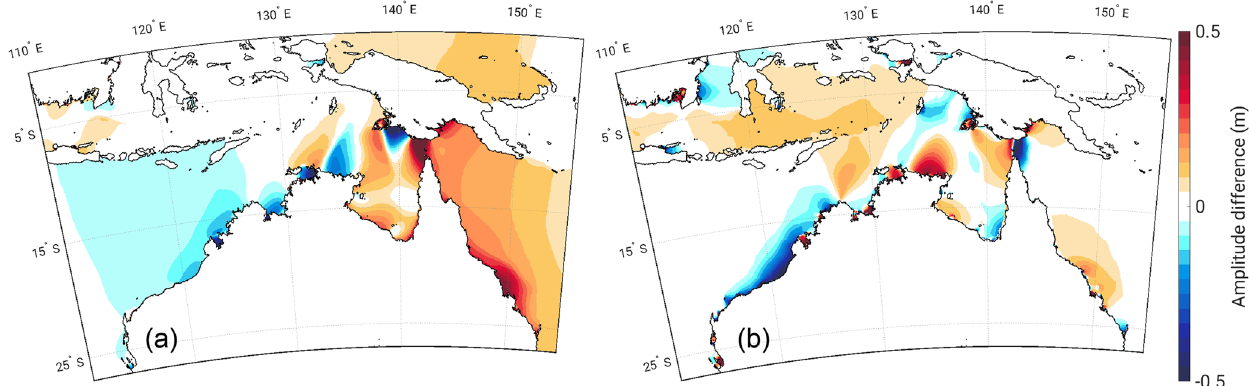
Figure 7. The difference in M 2 amplitude (m) between the FL and control simulation (i.e. FL–control) for 7m SLR using boundary conditions generated from a global 7m SLR scenario (a) and using boundary conditions generated from TPXO8 (b) .